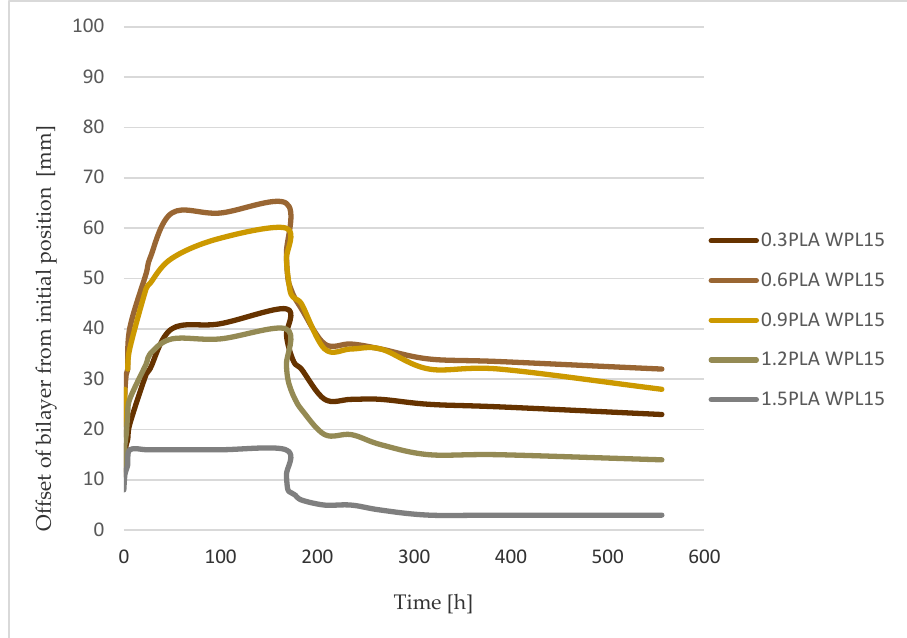
Figure 7. Curvature/offset from initial position of WPL15 bilayer actuators during humidification (up to 168 h) and drying cycle .